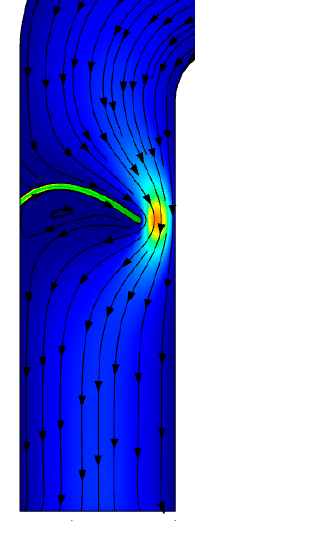
Figure 8. The operation of valve blocking when the piezoelectric component moves downwards ( L p = 5 mm, w = 5 µ m, h p = 130 µ m, V = 400 V).